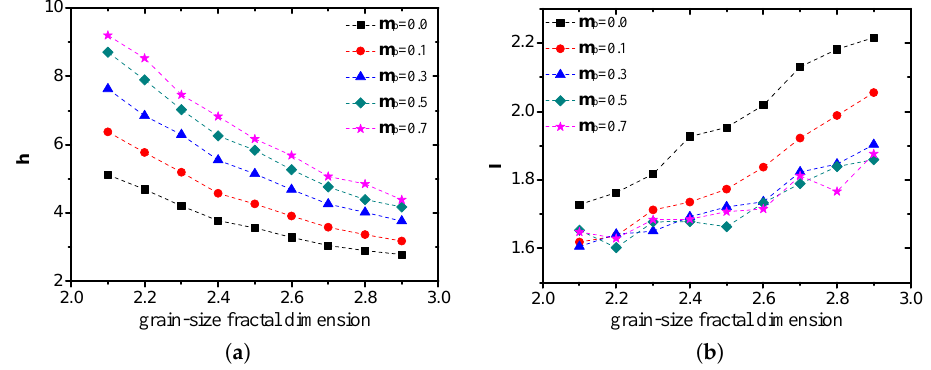
Figure 24. Variation in parameters with fractal dimension and friction coefficient (( a ) scale parameter η ; ( b ) shape parameter λ ).